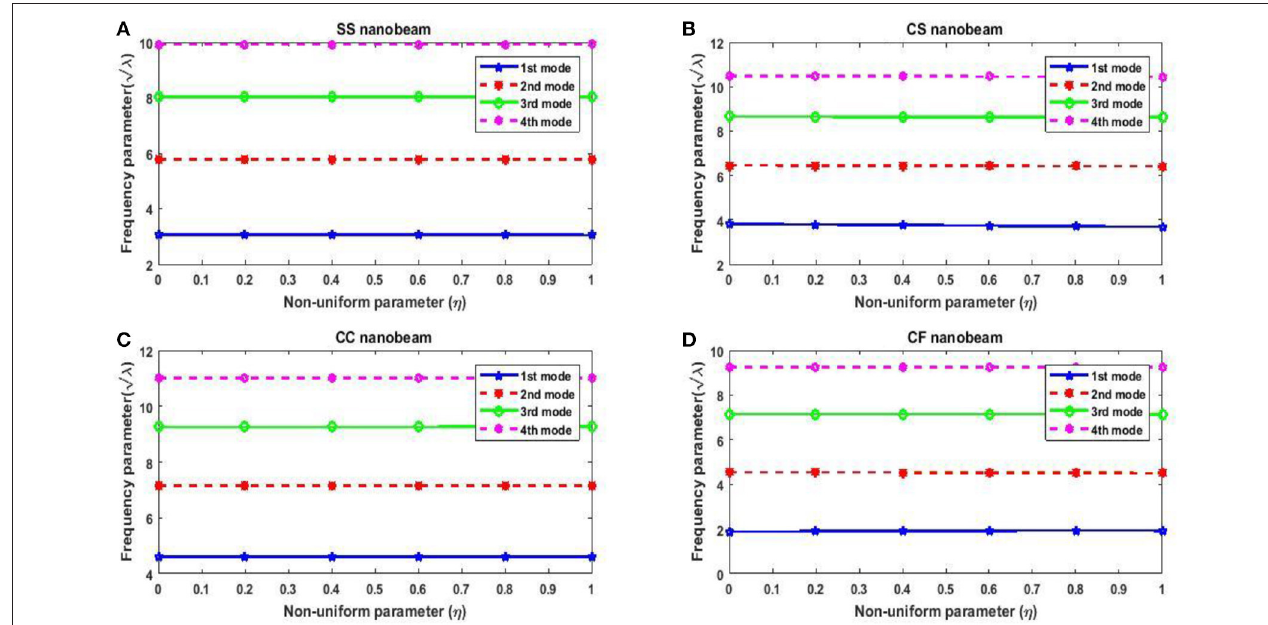
FIGURE 3 | Variation of frequency parameter with non-uniform parameter. (A) Variation of Non-uniform parameter for SS Nanobeam. (B) Variation of Non-uniform parameter for CS Nanobeam. (C) Variation of Non-uniform parameter for CC Nanobeam. (D) Variation of Non-uniform parameter for CF Nanobeam.